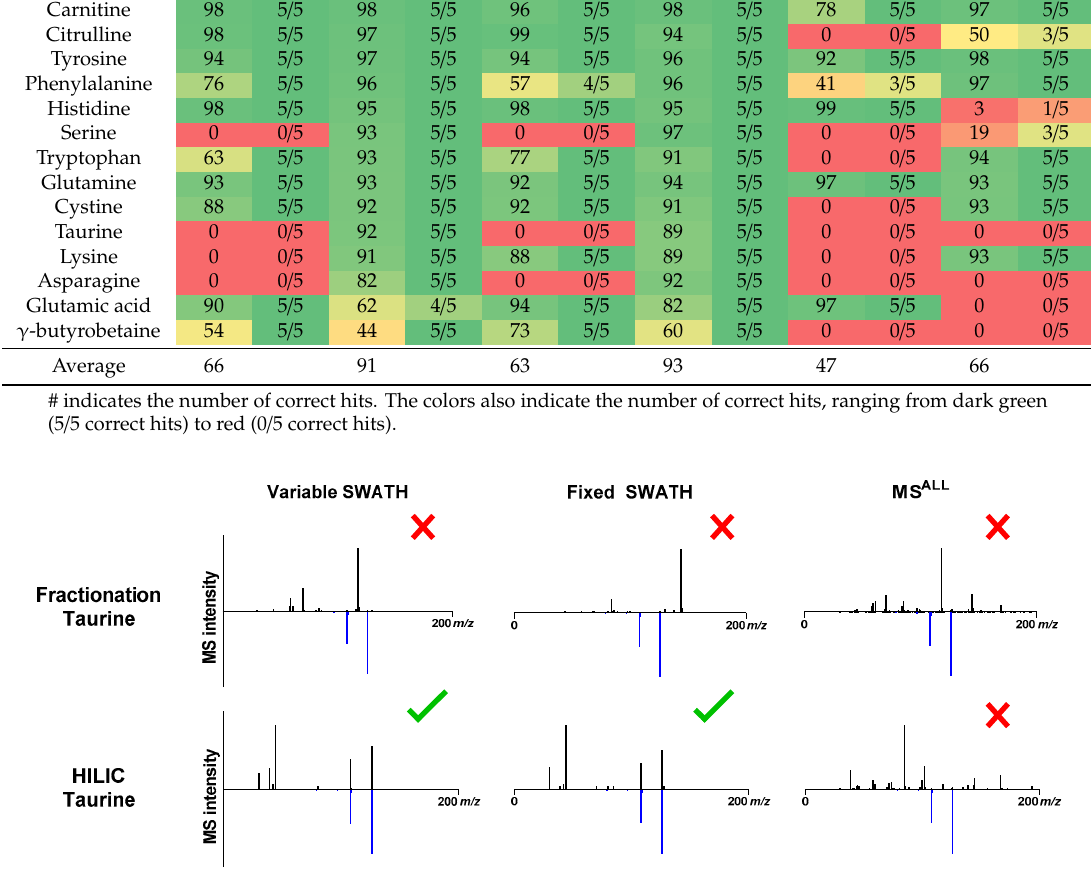
# indicates the number of correct hits. The colors also indicate the number of correct hits, ranging from dark green (5/5 correct hits) to red (0/5 correct hits).